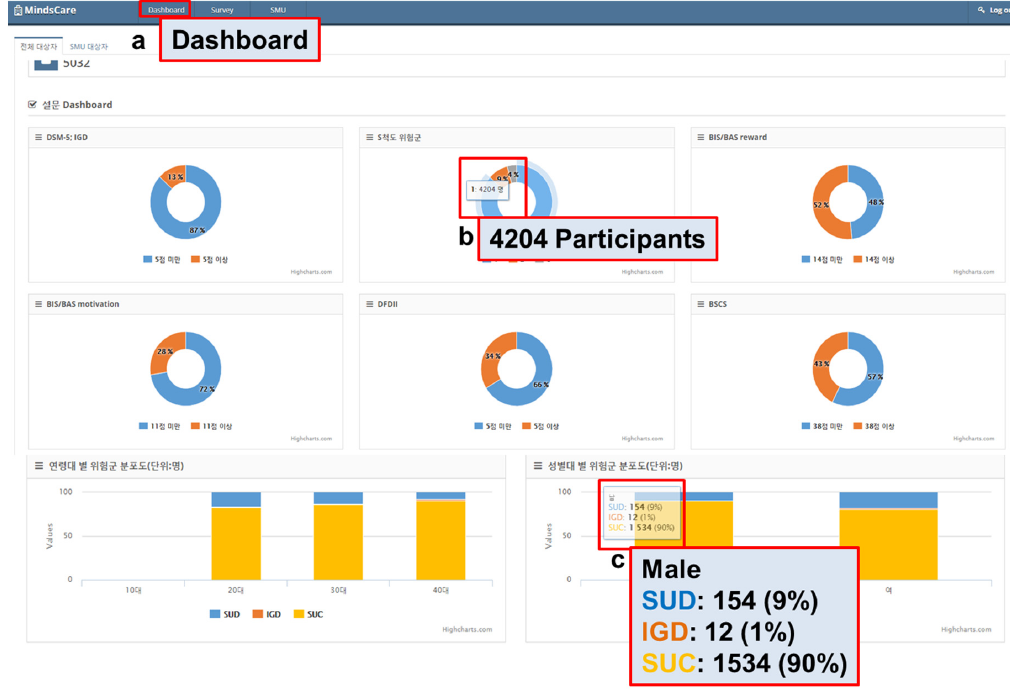
Figure 4. Survey data mining and visualization. SUD: Smartphone Use Disorder; IGD: Internet Gaming Disorder; SUC: Smartphone Use Control.